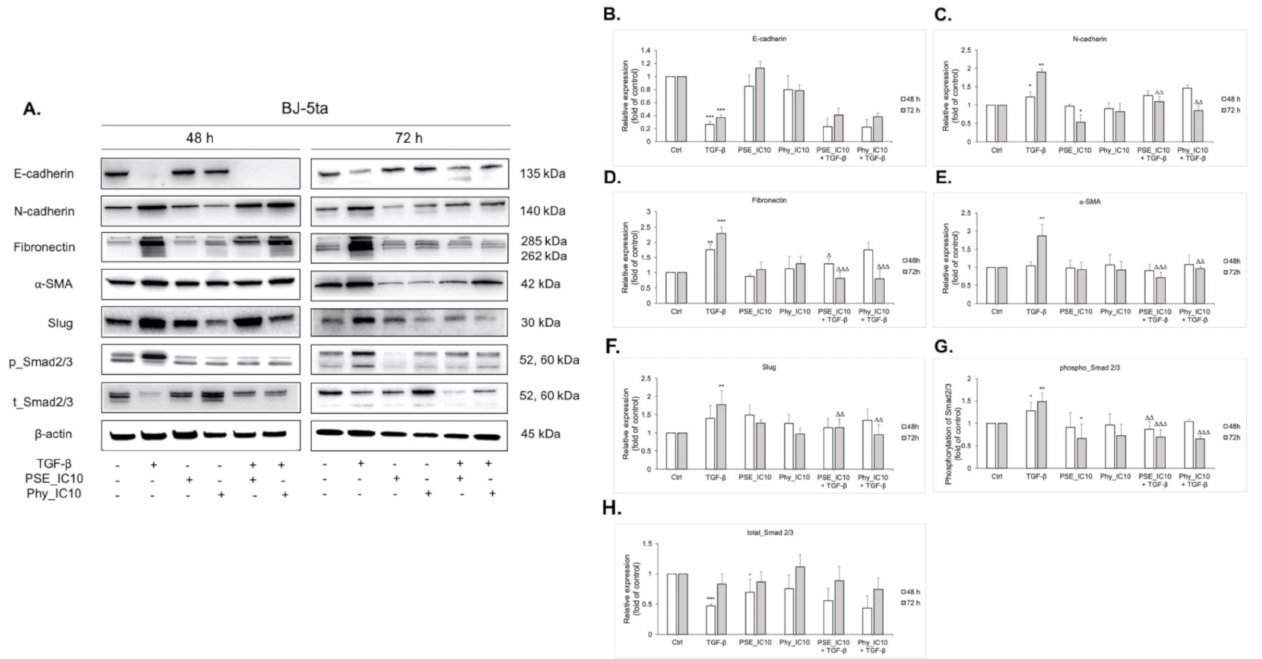
Figure 9. Analysis of the expression of EMT markers in BJ-5ta cells. ( A ) BJ-5ta cell lysates from treated or untreated cells were immunoblotted with different antibodies. The band intensity of E-cadherin ( B ), N-cadherin ( C ), fibronectin ( D ), alpha smooth muscle actin ( α -SMA) ( E ), Slug ( F ), p-Smad2/3 ( G ) and t_Smad2/3 ( H ) was quantified using the Image Studio Lite software. Quantification is relative to the control and normalised to β -actin expression (* p < 0.05, ** p < 0.01, *** p < 0.001 compared to control; ∆ p < 0.05, ∆∆ p < 0.01, ∆∆∆ p < 0.001 compared to TGF- β